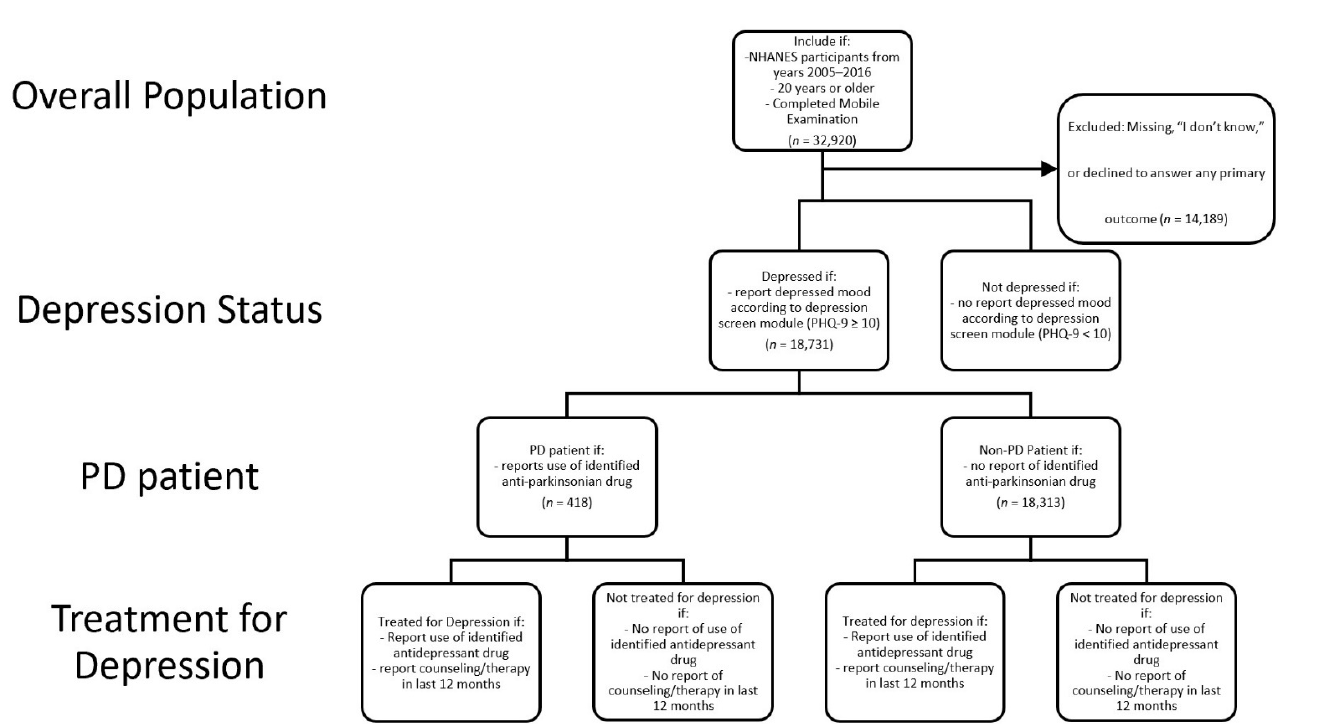
Figure 1. Schematic of participant sample selection, measures, and analysis.